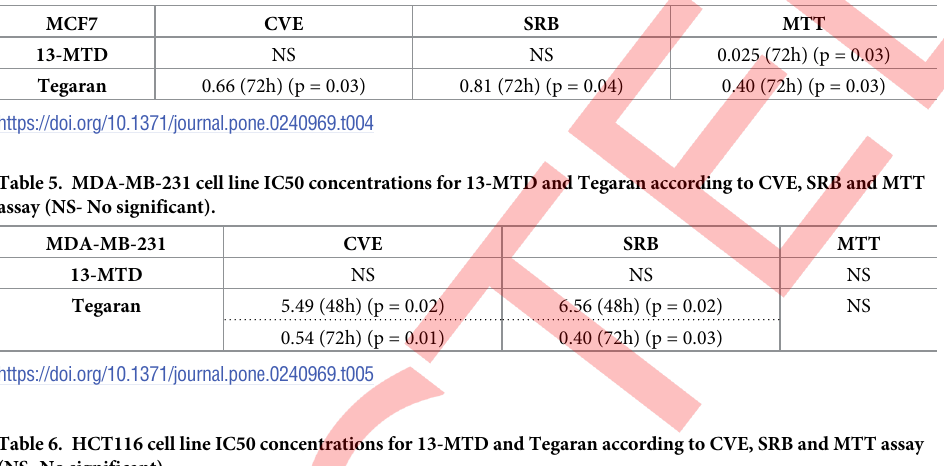
Table 4. MCF7 cell line IC50 concentrations for 13-MTD and Tegaran according to CVE, SRB and MTT assay (NS- No significant).